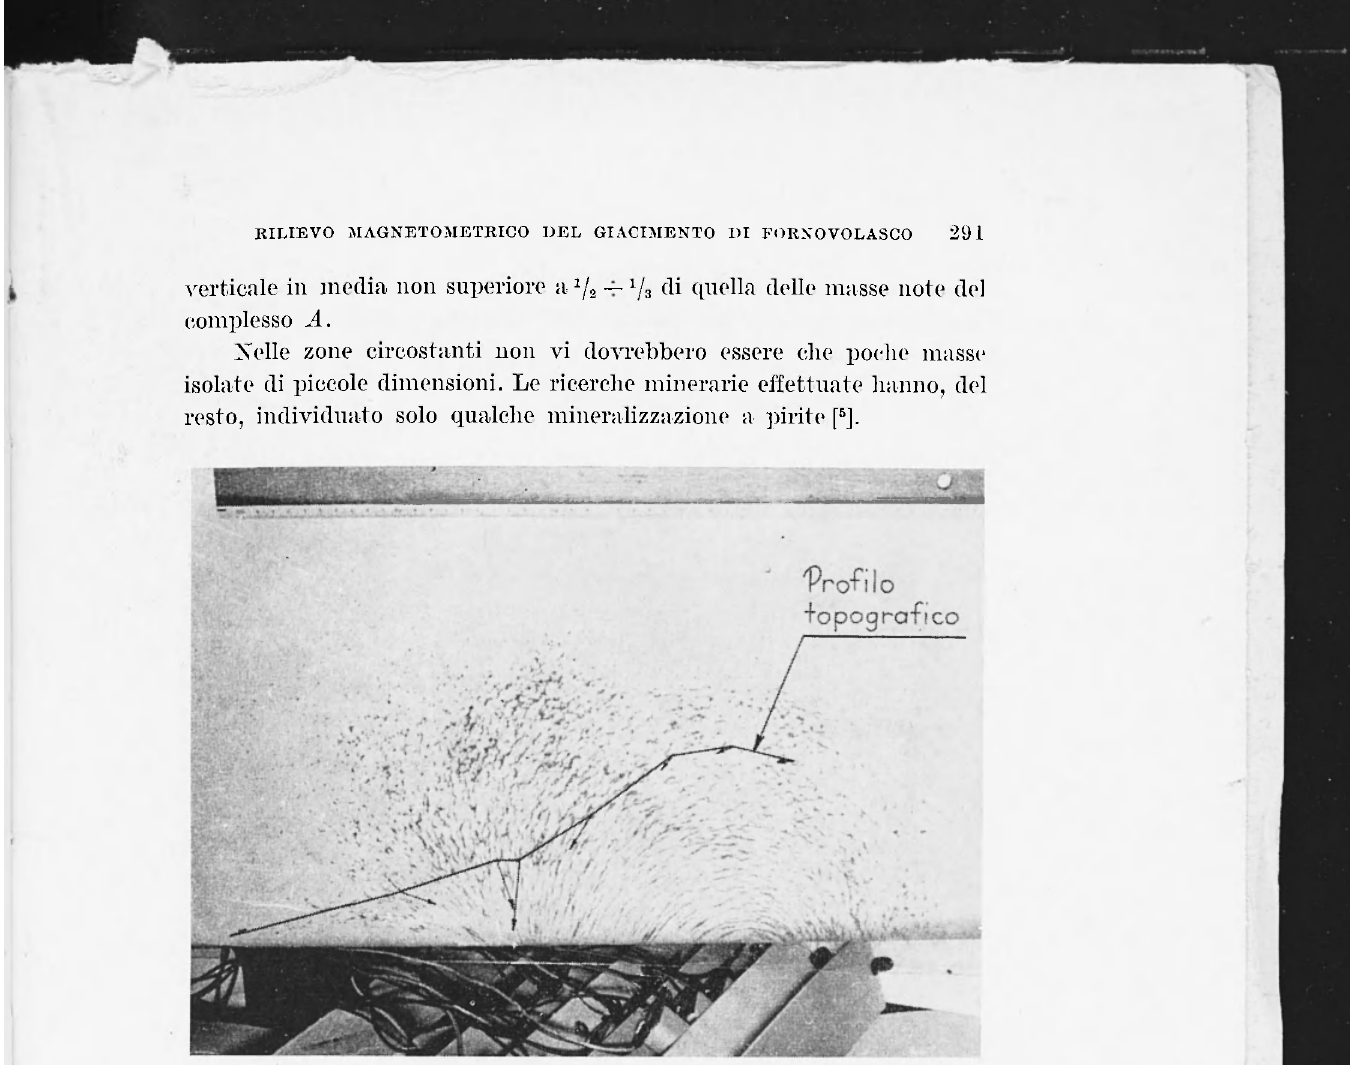
Fig. 7 - Andamento della proiezione del campo magnetico generato dalle elettrocalamite nel modello sul piano, corrispondente alla sezione verticale C-O' (vedi Fig. 3). Sono anche riportati il profilo topografico e le proiezio- ni, sulla sezione, dei vettori anomali totali determinati nelle varie stazioni interessate dalla sezione